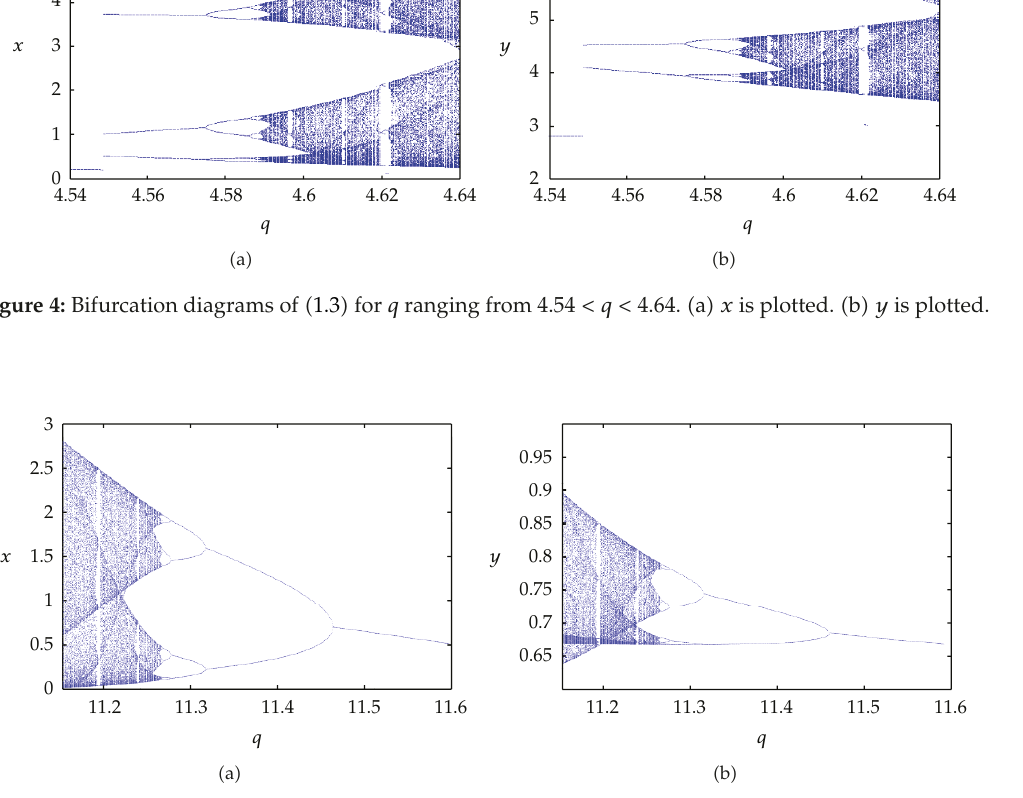
Figure 5: Bifurcation diagrams of (cid:3) 1.3 (cid:4) for q ranging from 11 . 153 < q < 11 . 6. (cid:3) a (cid:4) x is plotted. (cid:3) b (cid:4) y is